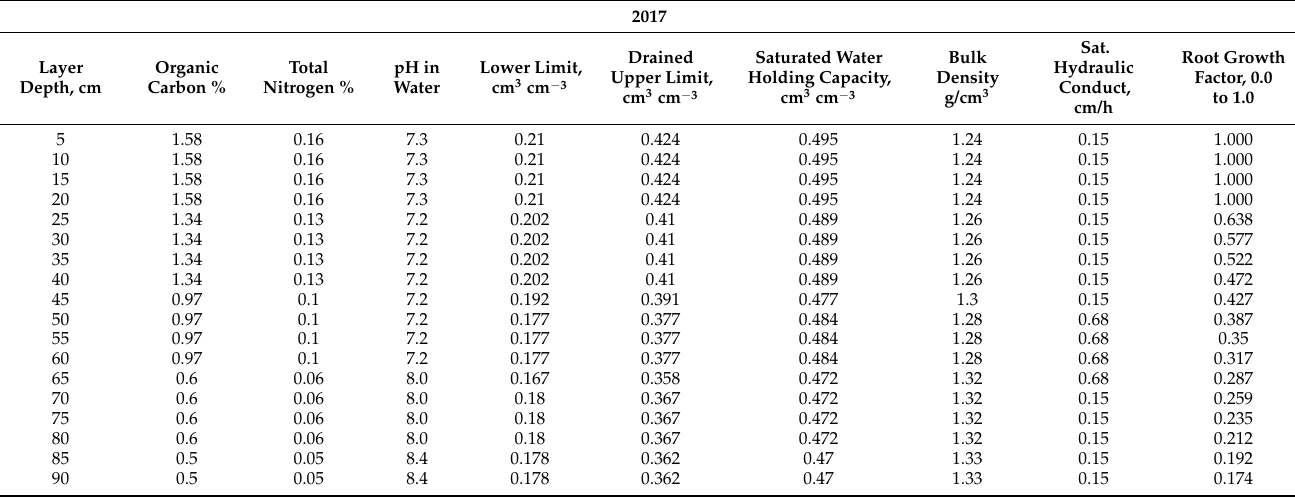
Table A1. The physical and chemical parameters of the soil in the experimental area in